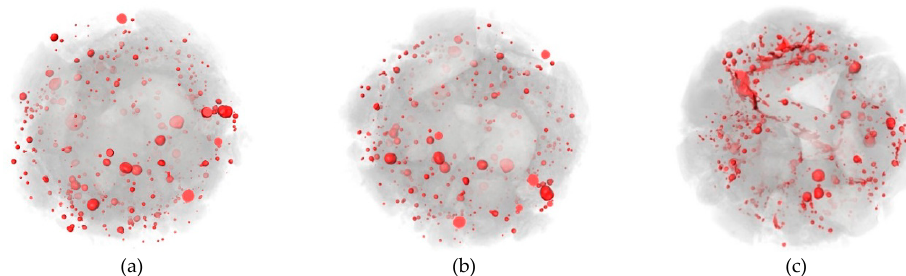
Figure 19. Pore distribution under different freezing and thawing cycles of 0.6% 30 nm-NT added concrete. ( a ) 25 FTCs; ( b ) 50 FTCs; ( c ) 75 FTCs.